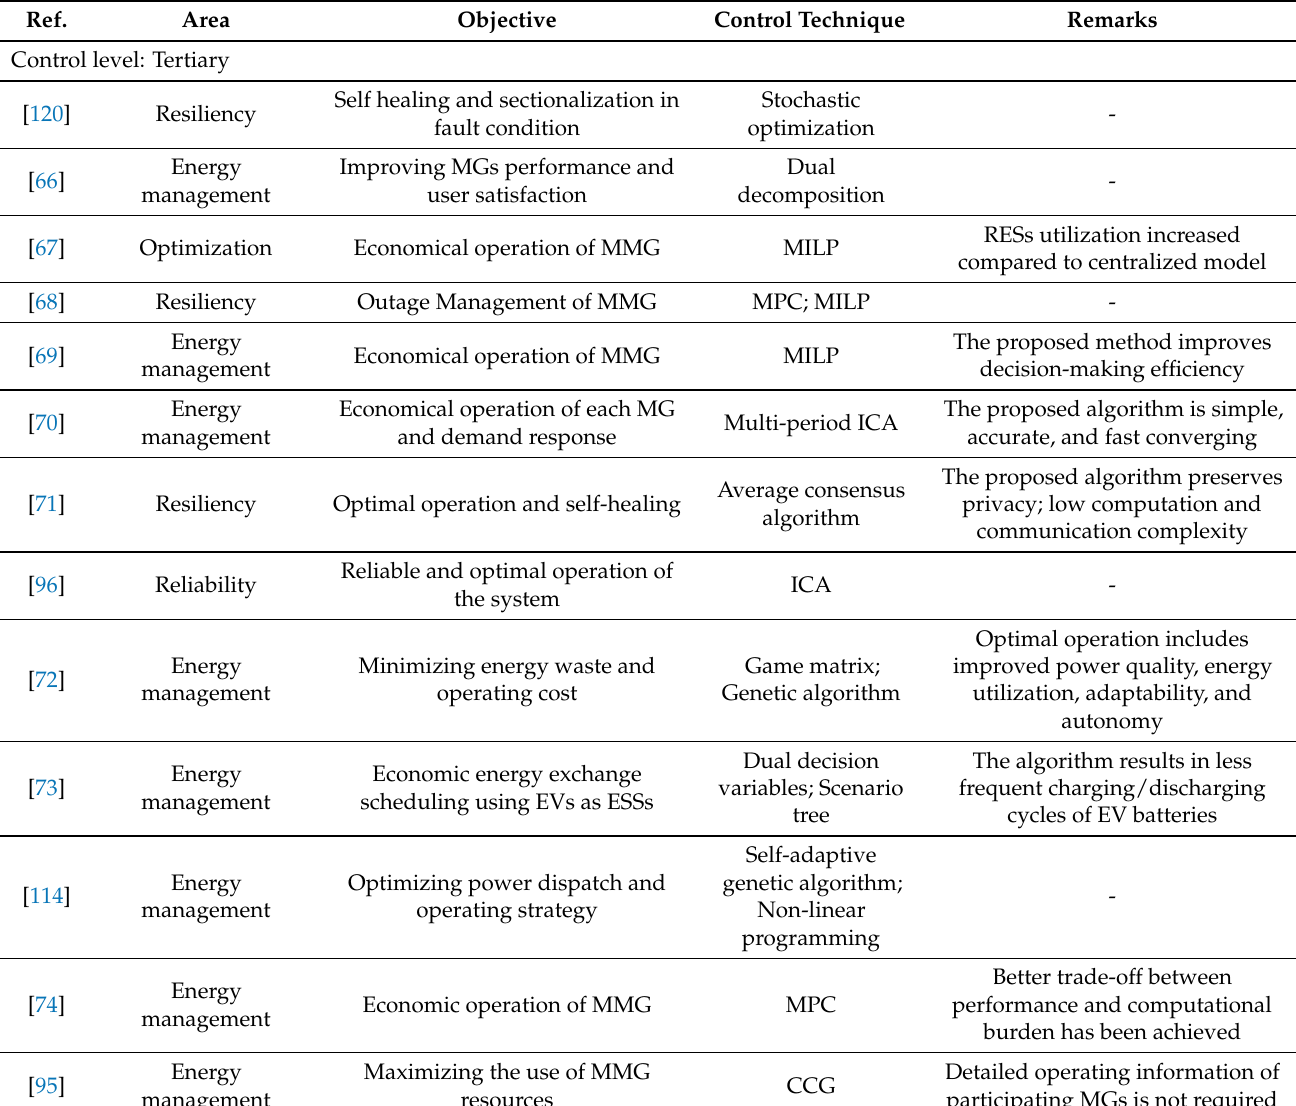
Table A4. Summary of the recently published articles on the hierarchical control of MMGs.